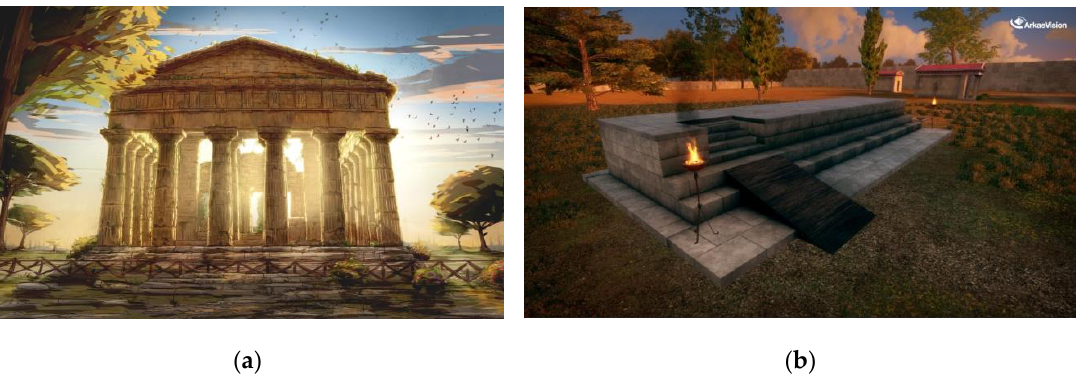
Figure 9. Screenshots taken from the VR application of ArkaeVision Archeo : ( a ) interior of the naos in 500 BC with the priestess Ariadne and ( b ) sacrificial altar in front of the temple. Copyright © Digitalcomoedia.